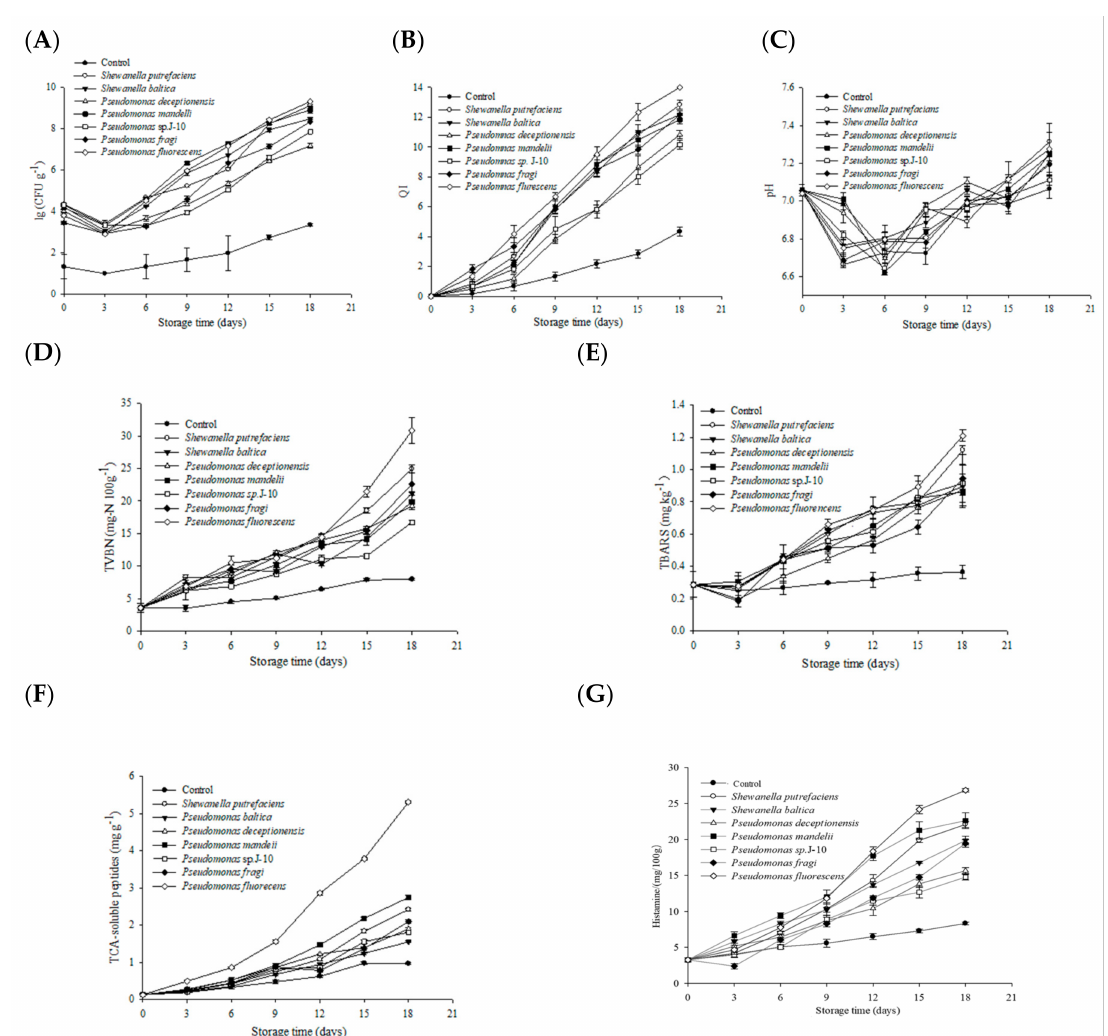
Figure 2. Growth of total bacteria ( A ), sensory ( B ), pH ( C ), total volatile base nitrogen (TVBN) production ( D ), thiobarbituric acid reactive substances (TBARS) ( E ), TCA-soluble peptides ( F ), and histamine ( G ) analysis of sturgeon fillets inoculated with different bacterial groups stored aerobically on